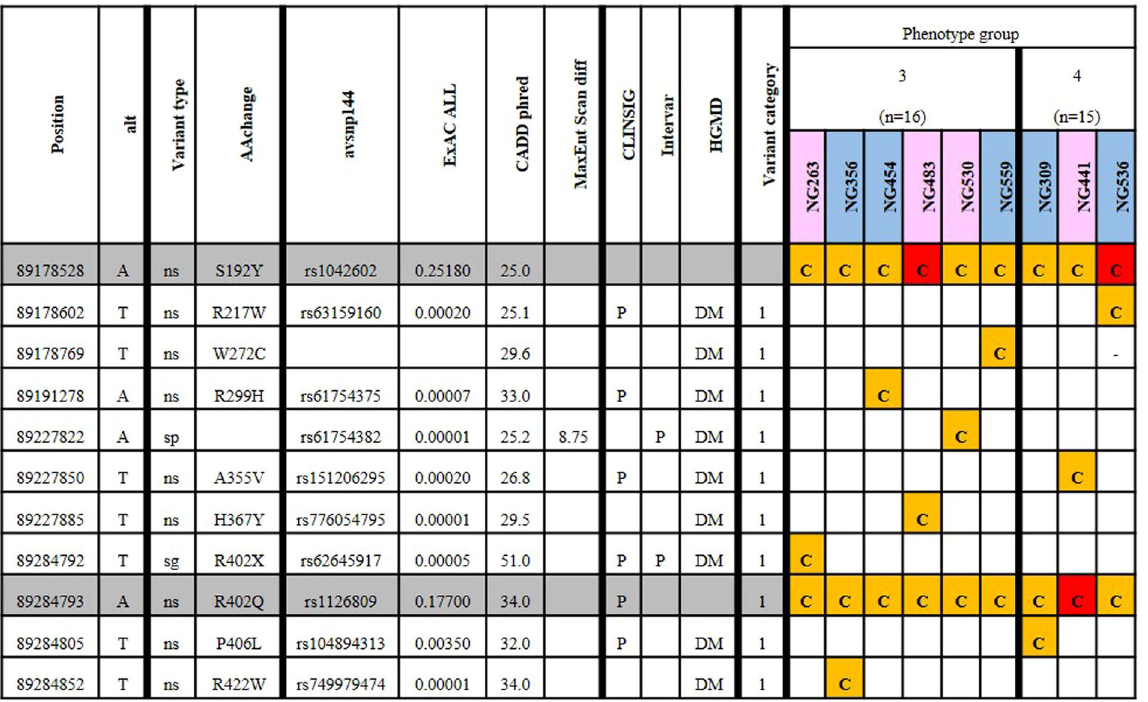
Figure 3. Nine samples were identified to have a likely causal tri-allelic genotype for albinism within TYR . For 55 patients which did not have likely causal genotypes with assumed pathogenic or assumed likely pathogenic variants, nine were identified to have tri-allelic causal genotypes in TYR . All TYR variants identified as assumed pathogenic or assumed likely pathogenic with the addition of S192Y and R402Q are listed. Position, location of 5 ′ base of variant in hg38; Alt, alternative allele; Variant type, consequence of the variant (s = synonymous, ns = nonsynonymous, sp = splicing, sg = stopgain); AAchange; avsnp144, dbSNP144 rsID; ExAC ALL, Alternate allele frequency from ExAC database (all populations); CADD Phred, Combined Annotation Dependent Depletion score (Phred scale); MaxEntScan diff, the difference in score between MaxEntScan reference allele and alternative allele; ClinSig, clinical significance (clinvar); InterVar, pathogenicity category according to InterVar interpretation; HGMD 2016 class, HGMD annotation for pathogenicity; Samples, orange indicates heterozygous variants, red indicates homozygous variants. Samples are ordered by phenotypic group, ‘c’ was used to indicate a likely causal variant, and grey highlights the common variants involved in the tri-allelic genotype outlined by Norman et al . (S192Y and